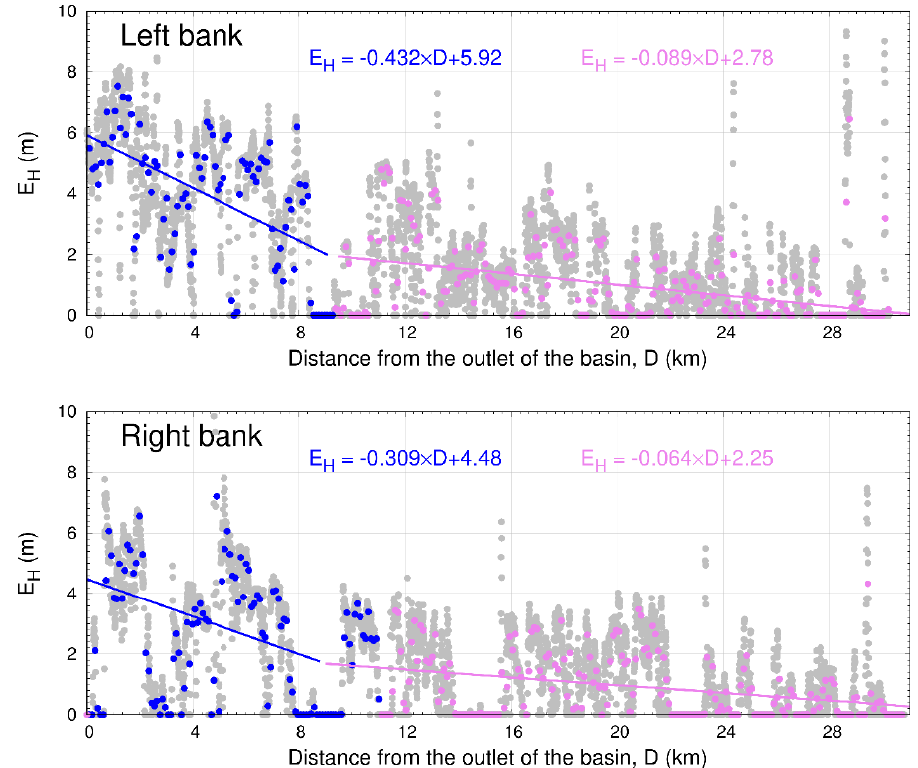
Figure 5. Embankment heights along the main river in the basin. Fitted lines were drawn by considering a moving average of 20 points in the original datasets.